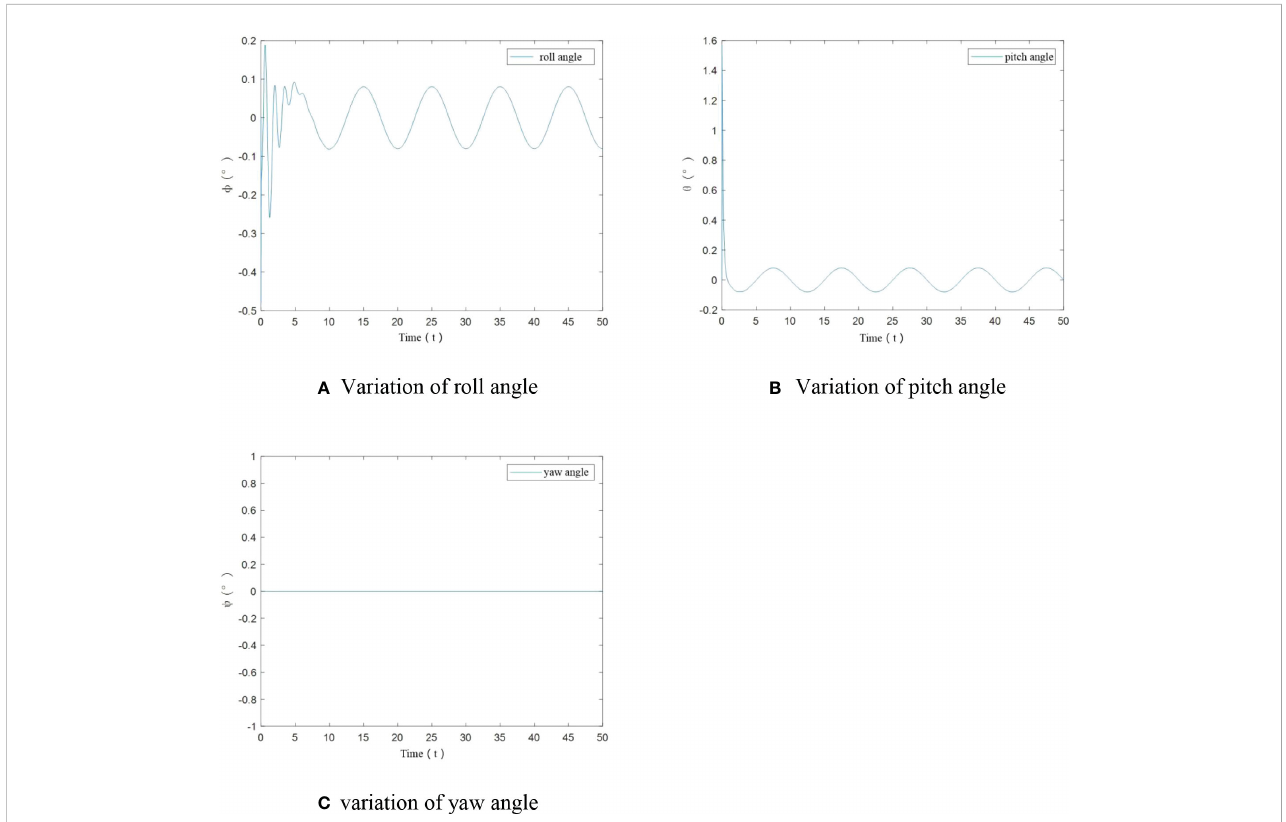
FIGURE 6 Angle variation of UAV under no-load condition. (A) Variation of roll angle, (B) Variation of pitch angle, (C) variation of yaw